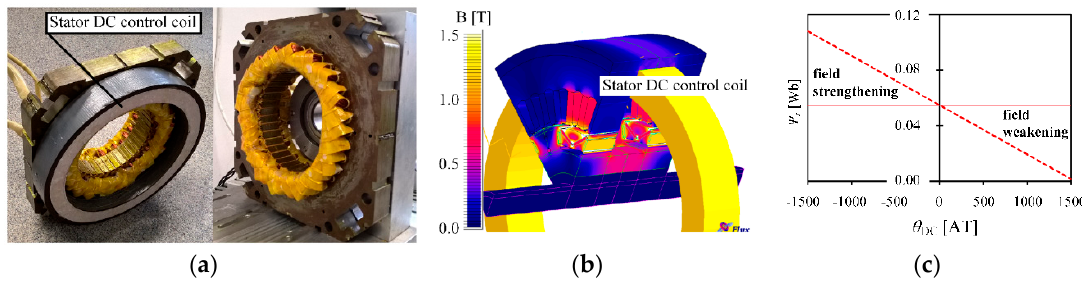
Figure 4. ( a ) The stator DC control coil location in the prototype; ( b ) 3D-FEA model; ( c ) Results of no-load magnetic flux linkage Ψ s vs. DC coil MMF of ECPMS-machine design [54].